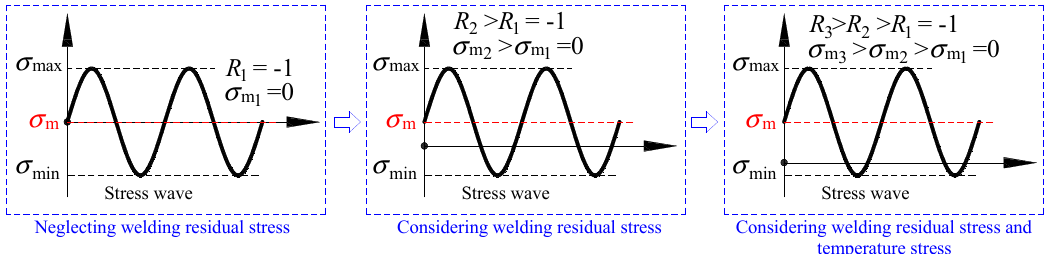
Figure 1. Variation of stress ratio induced by residual temperature stress.